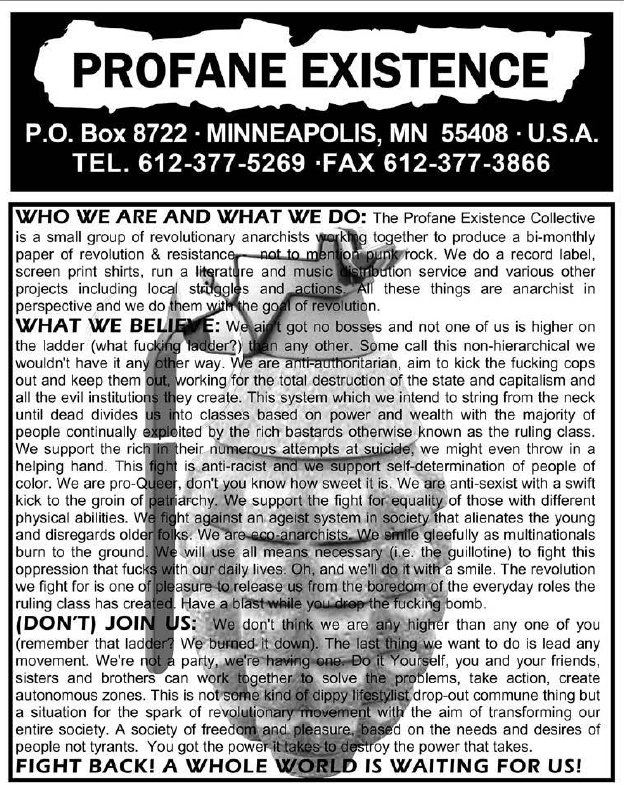
Figure 1. Profane Existence: Who We Are.